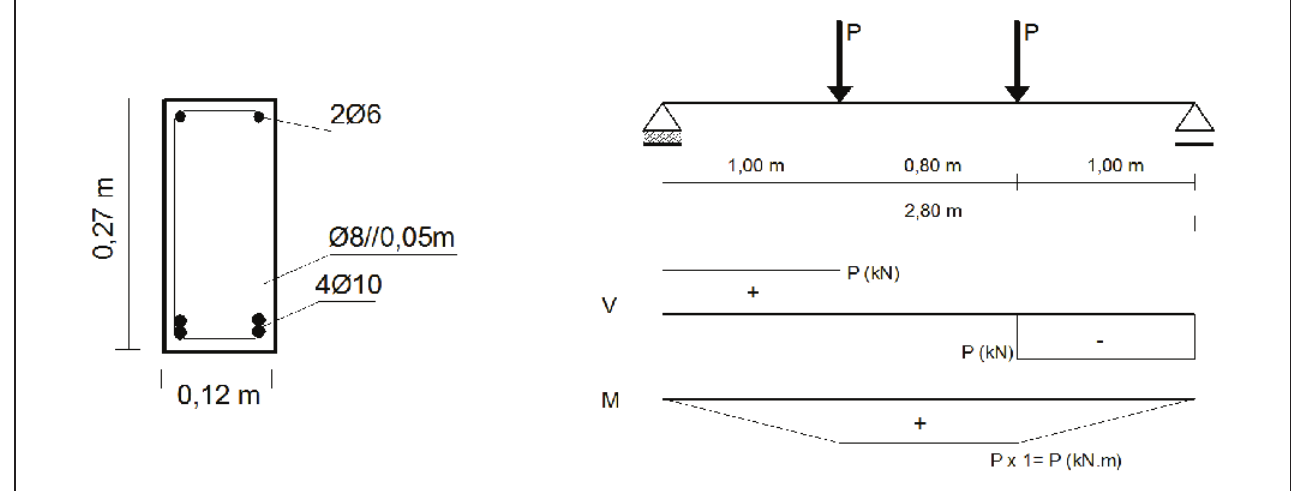
Figure 4 – Cross section, structural scheme, shear force and bending moment diagrams